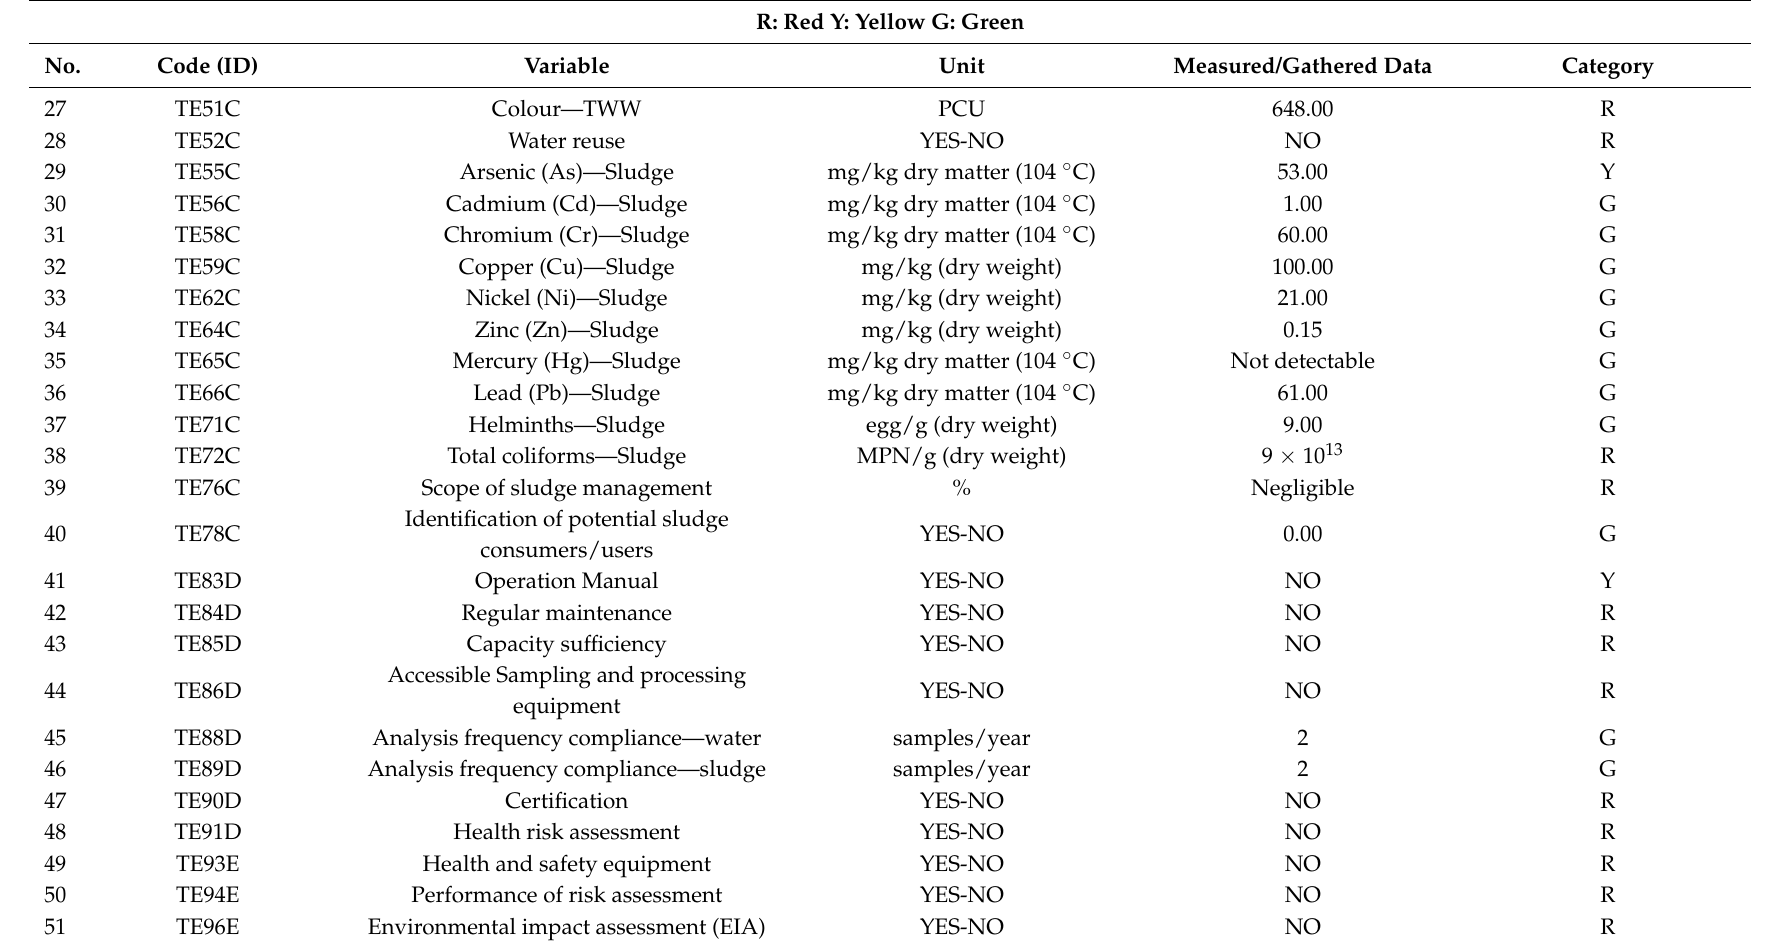
Sustainability Assessment Results Per Variable (Panajachel, Guatemala) R: Red Y: Yellow G: